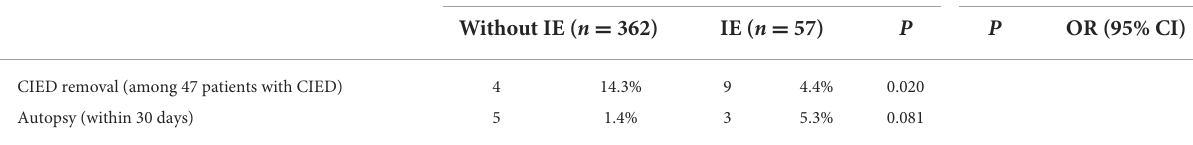
b Comparisonoftimetobloodculturepositivity < 9hagainst ≥ 9. 18-FDG PET-CT, 18-fluorodeoxyglucose positron emission tomography-computed tomography; CIED, cardiac implantable electronic devices; CRP, C-reactive protein; ESC, European SocietyofCardiology;IE,infectiveendocarditis;TTE,transthoracicechocardiography;TOE,transoesophagealechocardiography.